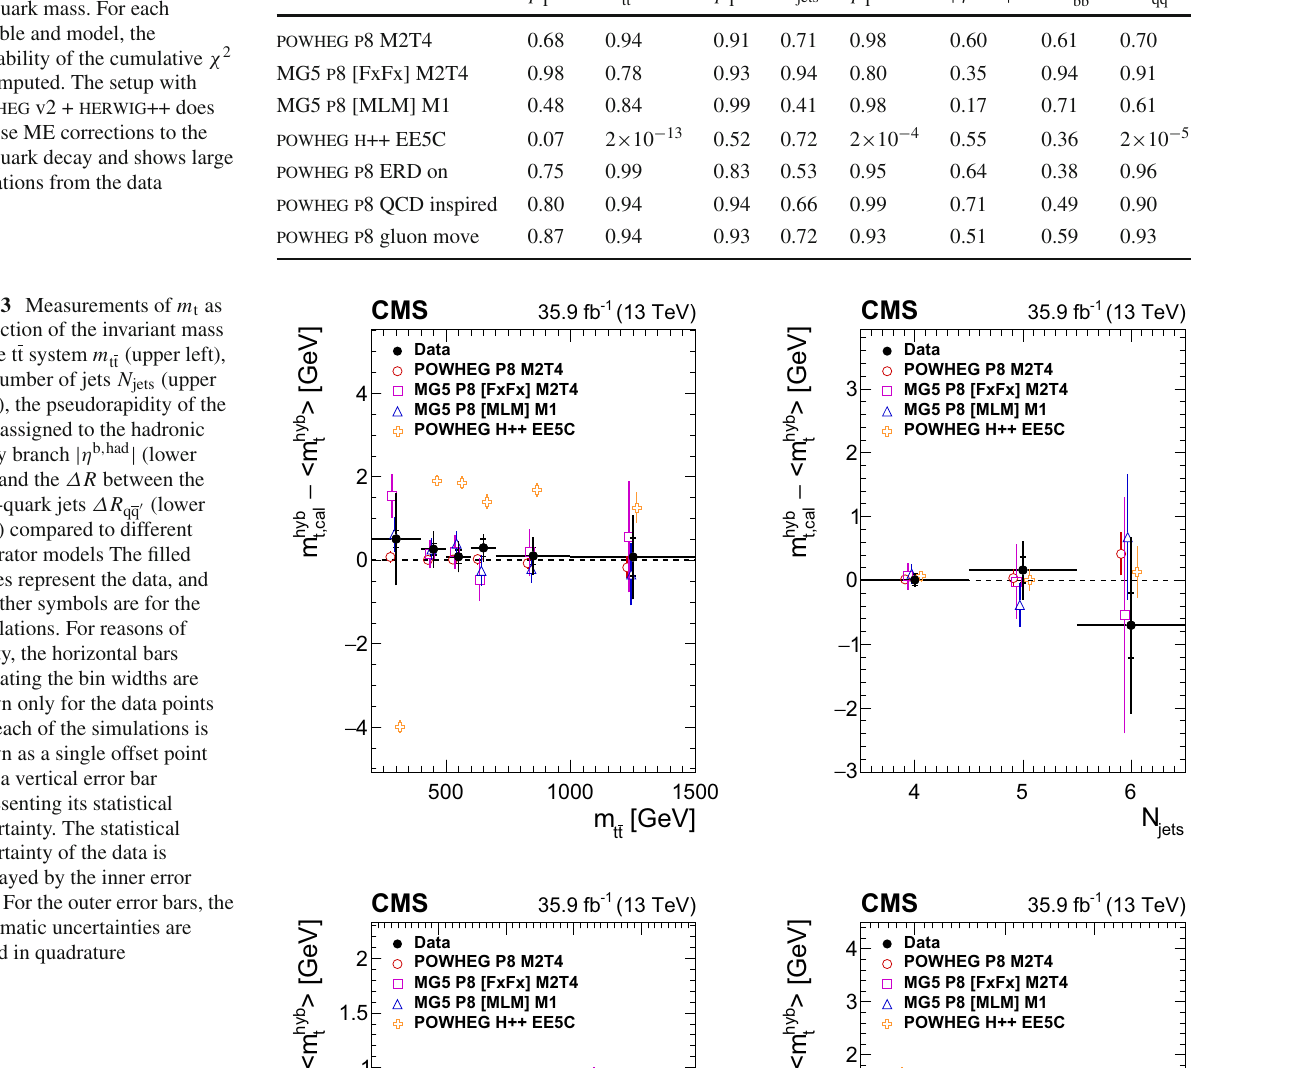
different models with the differential measurement of the top quark mass. For each variable and model, the probability of the cumulative χ 2 is computed. The setup with powheg v2 + herwig++ does not use ME corrections to the top quark decay and shows large deviations from the data